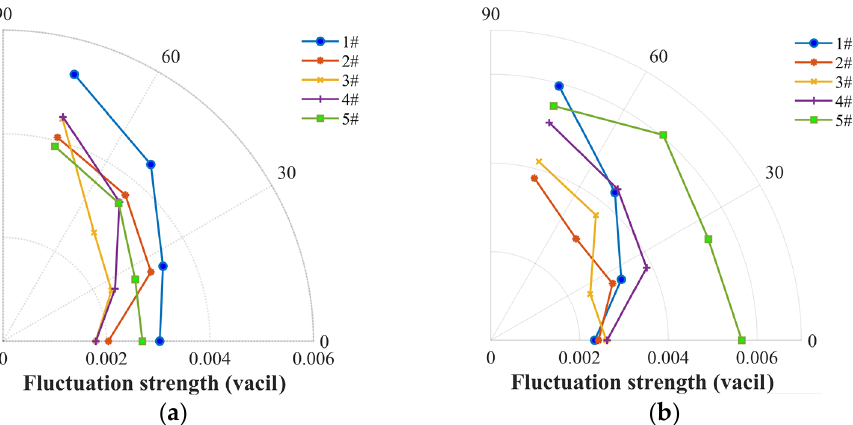
Figure 16. Comparison of fluctuation strength among the two-blade propeller (#1), four-blade propeller (#2), loop-type propeller (#3), wide chord loop-type propeller (#4), and DJI Phantom III propeller (#5) at a rotational speed of 5400 rpm ( a ) and at a stable thrust of 3 N ( b ).